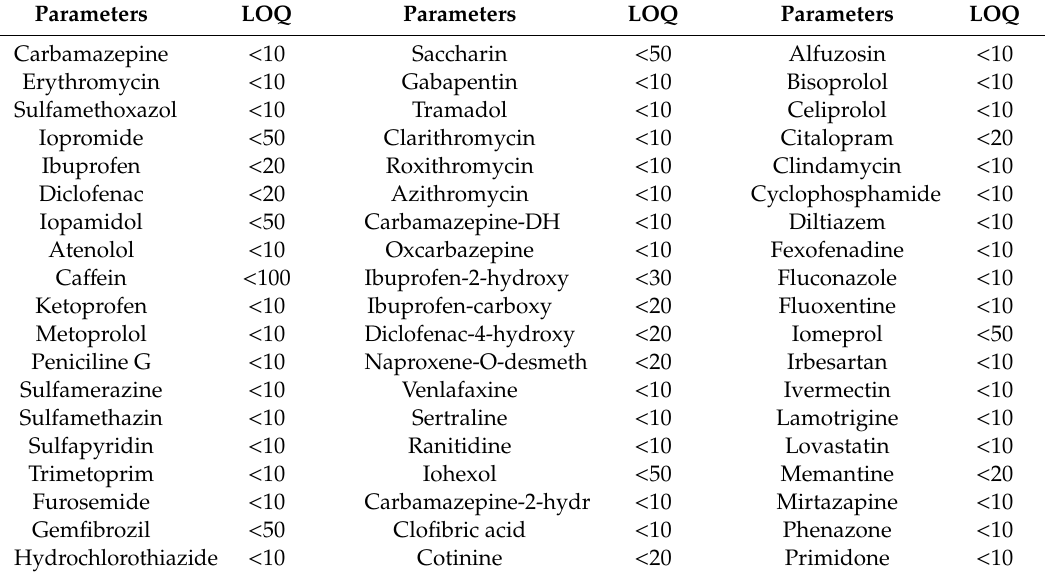
Table 2. List of substances tested in extended investigation (July, August, October